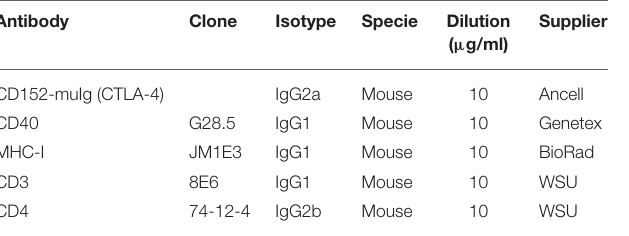
TABLE 3 | Antibodies used for maturation markers expressions and allogeneic lymphocytes proliferation assays. Antibody Clone Isotype